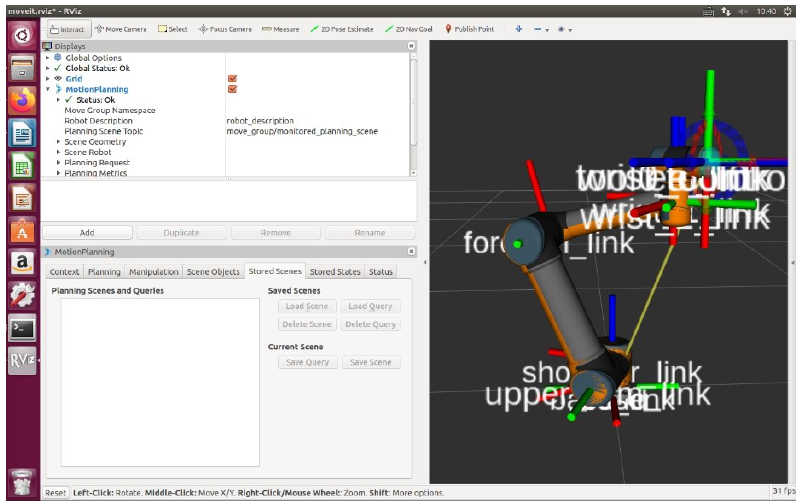
Fig. 2 MoveIt! plugin of